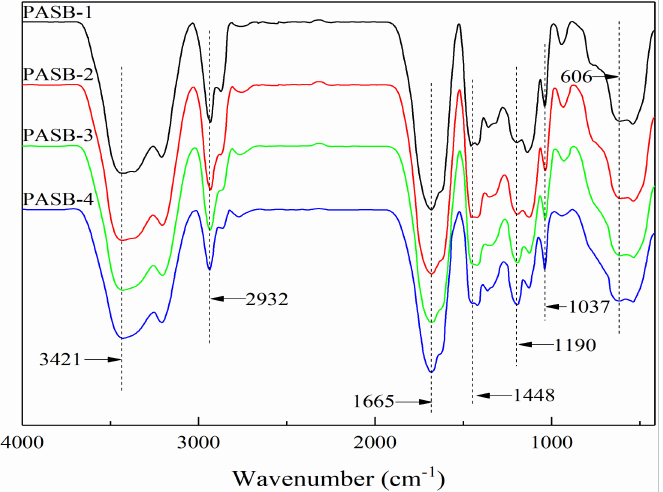
Figure 2. Fourier transform infrared spectra of copolymers